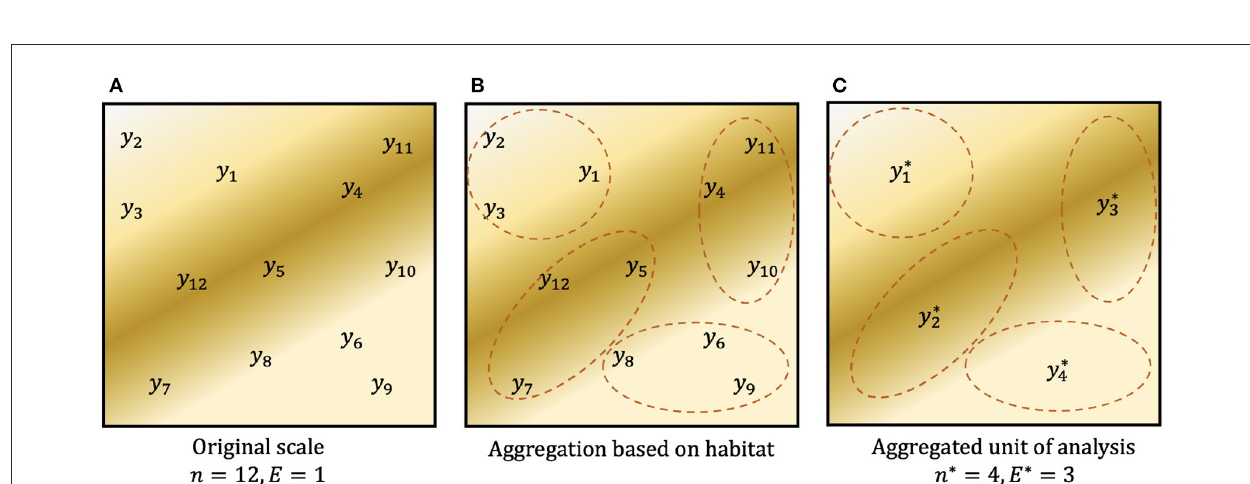
FIGURE1 Example graphic of aggregating count data. (A) Observed counts y 1 , ... , y 12 at single plots ( E = 1) within a spatial region. Background color denotes the spatial distribution of an environmental predictor such as habitat. (B) Possible aggregation of the original data based on habitat. (C) Data aggregated to a new unit of analysis, where y ∗ 1 = y 1 + y 2 + y 3 , and similarly for the other three aggregated observations. On this unit of analysis, there are n ∗ = 4 observations, each obtained with aggregated observation effort E ∗ = 3. In both (A, C) , total sampling effort is S =